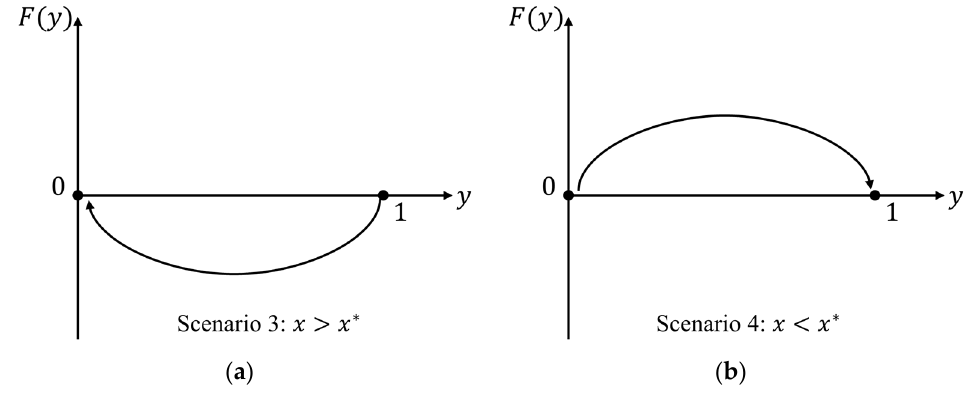
Figure 4. (a) The dynamic trend of the LF’s strategy in the case of 𝑥 > 𝑥 ∗ ; (b) The dynamic trend of Figure 4. ( a ) The dynamic trend of the LF’s strategy in the case of x > x ∗ ; ( b ) The dynamic trend of the LF’s strategy in the case of 𝑥 < 𝑥 ∗ . the LF’s strategy in the case of x < x ∗